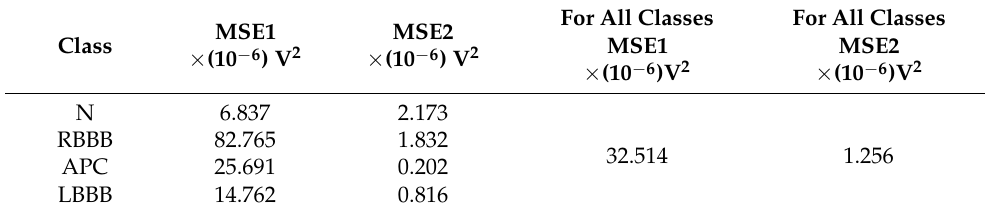
Table 1. Mean reconstruction errors.